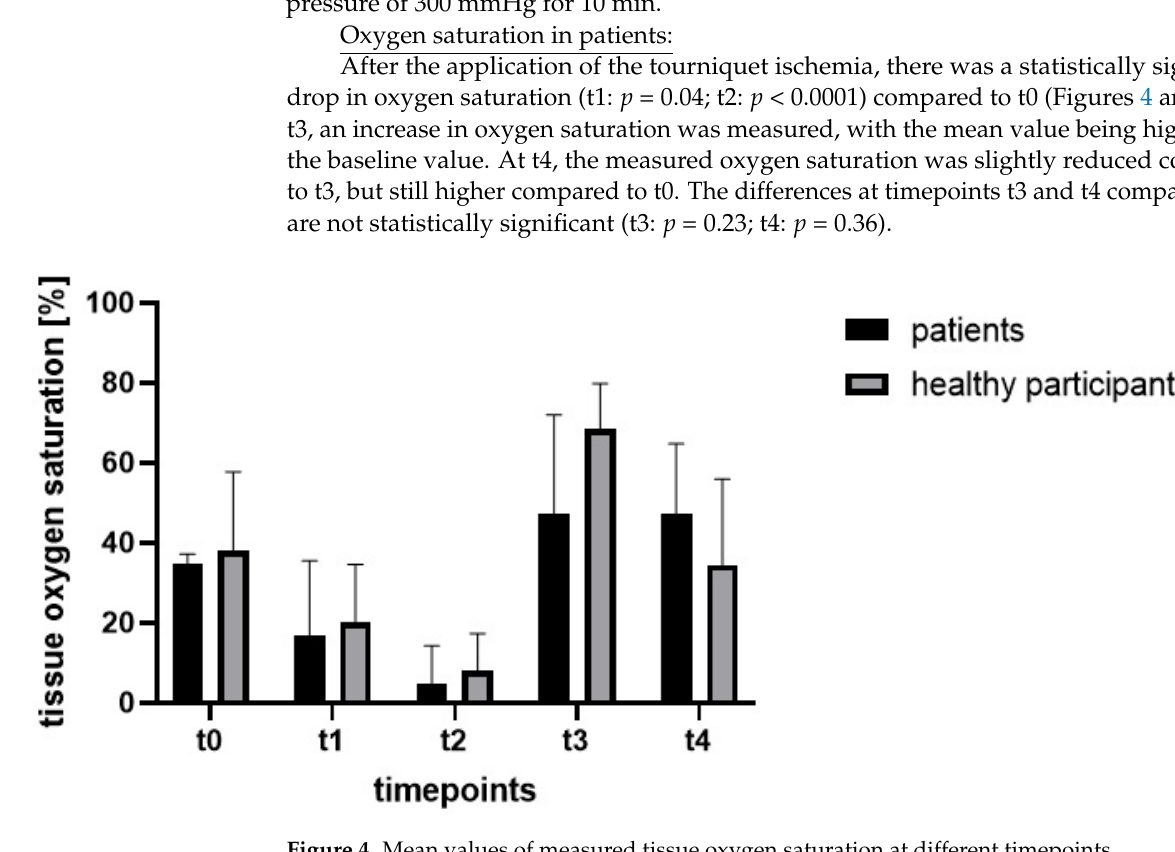
Figure 5. Tissue oxygen saturation of a patient’s hand at different timepoints.